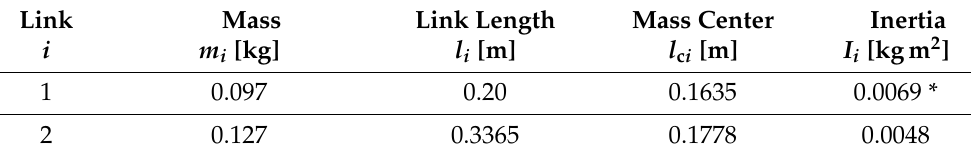
Table 3. Pendubot robot